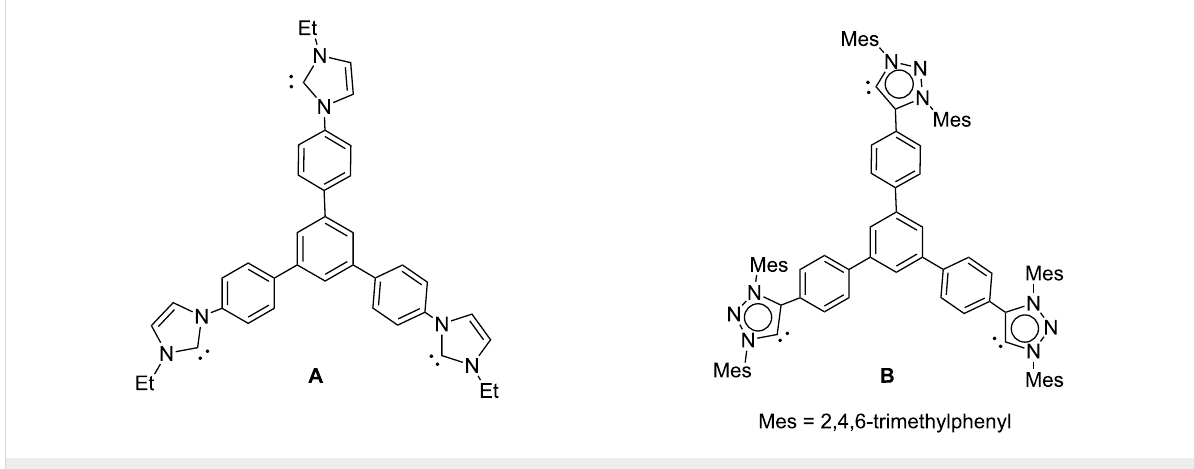
Scheme 1: Schematic representation of ligands A and B